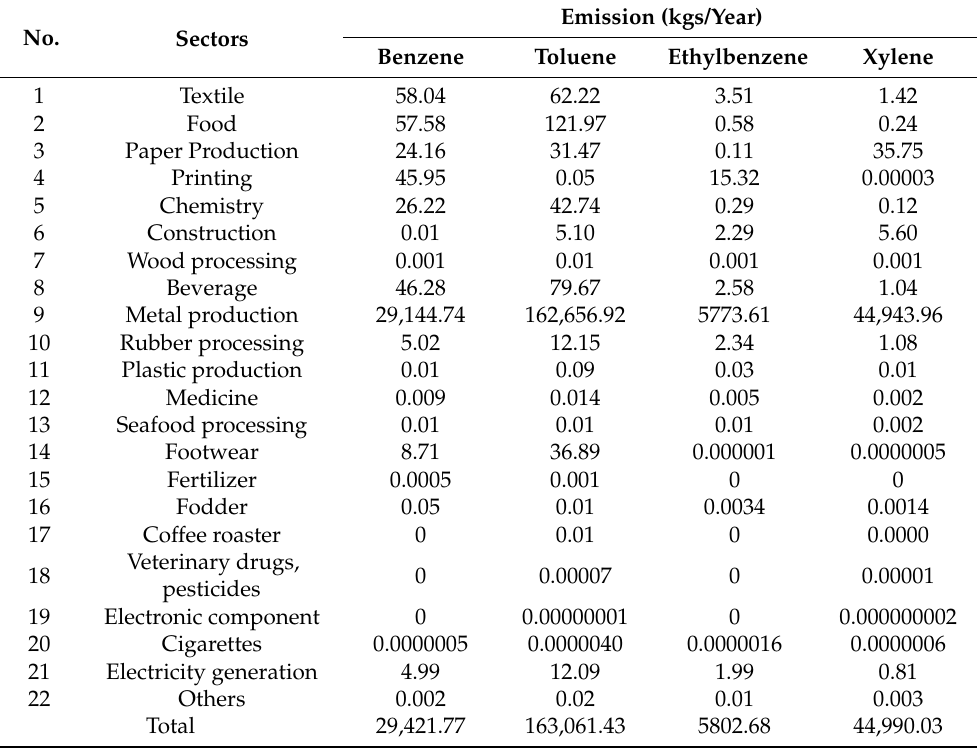
Table 3. BTEX emission (kgs/year) from industrial sources due to producing and combustion activities in Ho Chi Minh City in